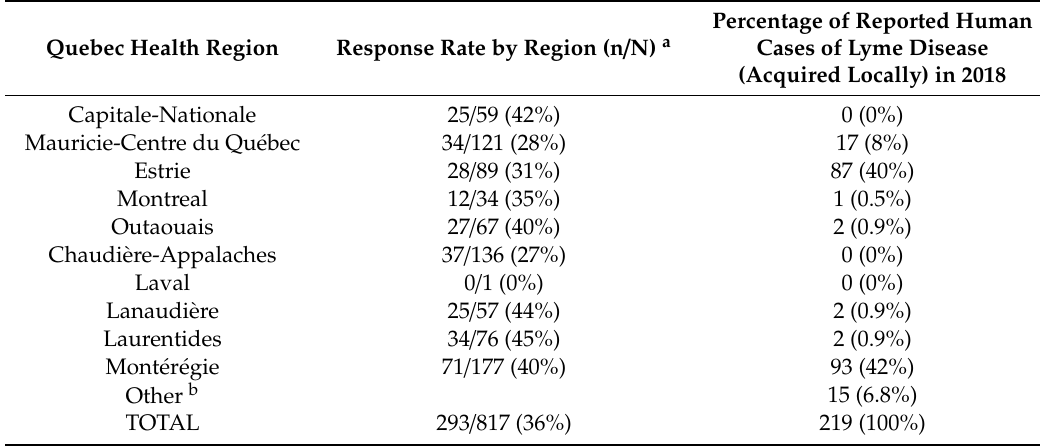
Table 1. Response rate by health region.